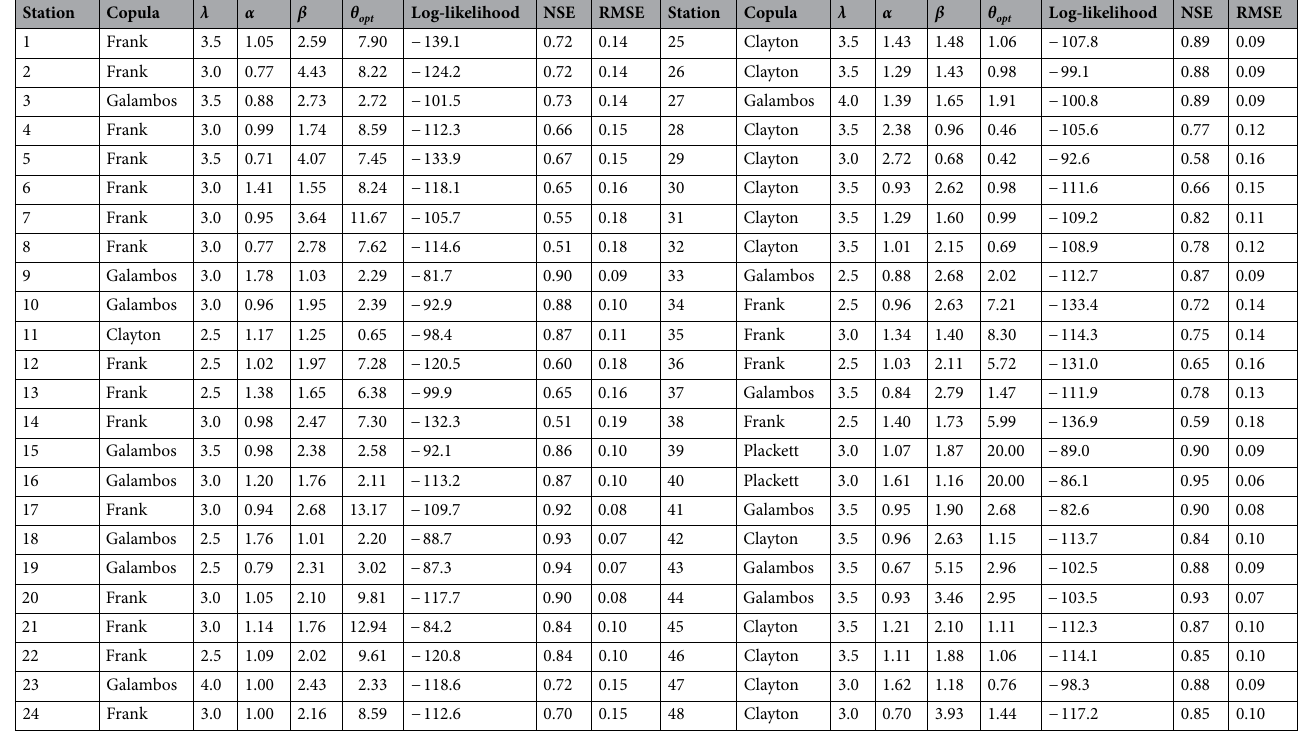
Table 1. Meteorological drought: a summary of statistical parameters for the fitted marginal distributions and copulas in 48 synoptic